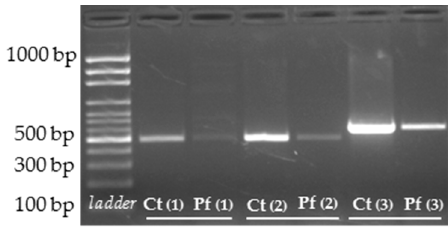
Figure 2. RT-PCR amplification of RNA extracted from the proband’s father (Pf), carrier of the novel c.1213+5G>T [IVS6+5G>T] mutation. Total ARSB cDNA was amplified in three different fragments (1–3). The amplification of a control sample (Ct) is also presented.